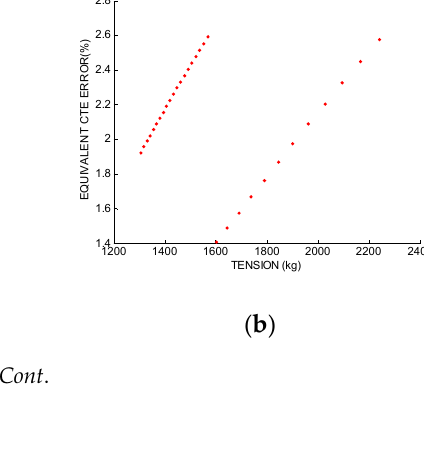
Table 4. Equivalent CTE